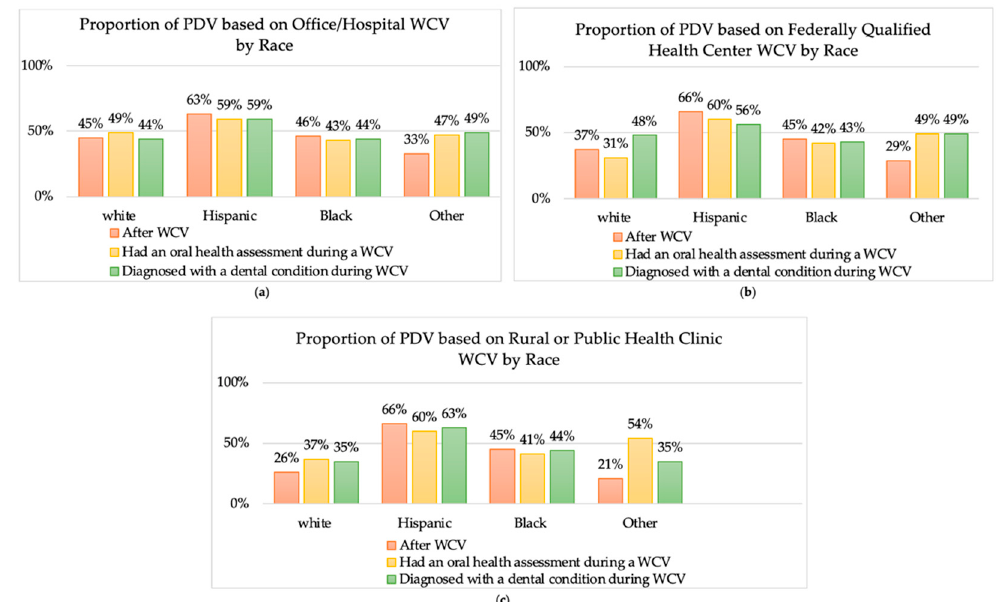
Figure 1. Proportion of children with a preventative dental visit (PDV) among patients with prior well-child visit (WCV), with an oral health assessment during a WCV, or diagnosed with a dental condition during a WCV, by race. ( a ) proportion of PDV after WCV at office /Hospital by race. ( b ) proportion of PDV after WCV at Federally Qualified Health Center by race. ( c ) proportion of PDV after WCV at Rural Public Health Clinic by race.